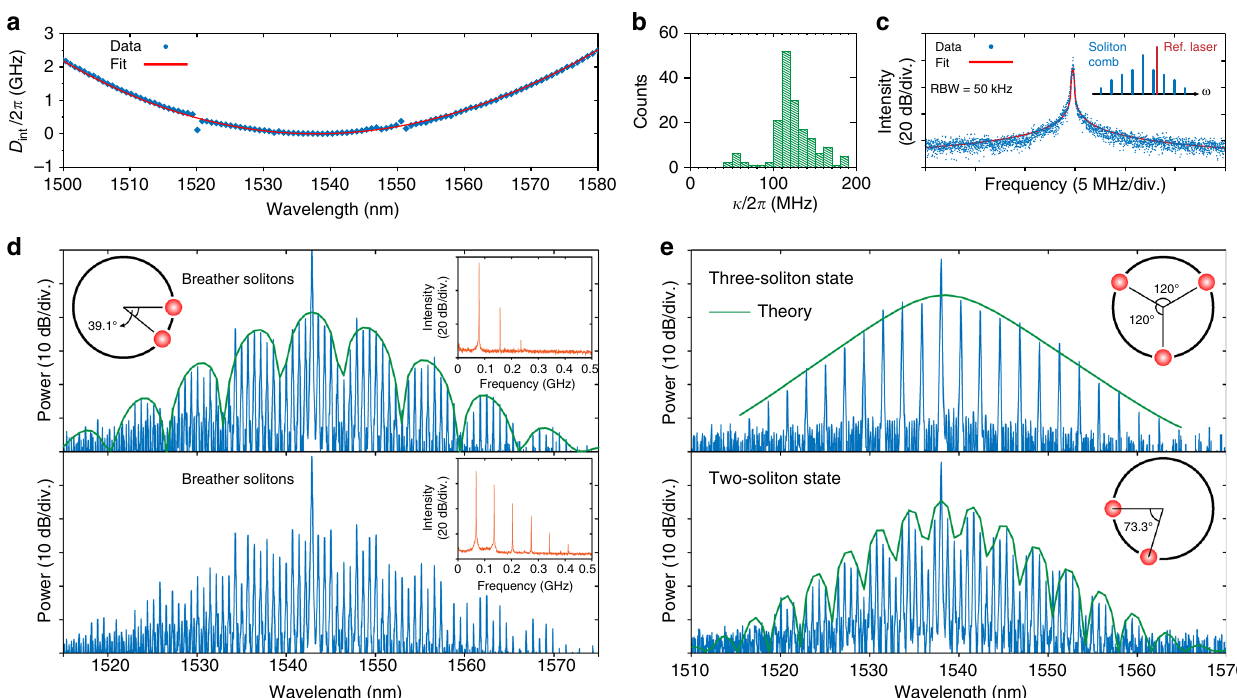
Fig. 4 Laser injection-locked multiple breathing and dissipative Kerr solitons. a Measured and fi tted dispersion landscape in a Si 3 N 4 microresonator (cross- section 1.58 × 0.75 μ m 2 ) (cf. Methods), which has the FSR = 92.4 GHz, and the second-order dispersion element indicating the anomalous group velocity, D π ≈ 1.56 MHz. b Histogram of resonance linewidths that are ~110 MHz, corresponding to a loaded Q -factor ~1.8 × 10 6 . c Heterodyne beat signal 2 /2 between the sideband of soliton Kerr frequency comb and the narrow linewidth reference laser. The measured beat signal is fi tted with Voigt pro fi le with full-width at half-maximum (FWHM) ~201 kHz (cf. Methods). RBW: Resolution bandwidth. d , e Showcase of multiple dissipative solitons formed in Si 3 N 4 microresonators, in the breathing state ( d ) as well as in the low-noise stable soliton state ( e ), the fi tting of the spectrum envelope (green-solid lines) further shows the relative position of solitons circulating in the micro-ring cavity (schematic insets). The low-frequency RF spectra corresponding to breather solitons are also shown as insets. Spectra in d and e are generated in Si 3 N 4 microresonators with a free spectral range (FSR) of ~88 and ~92